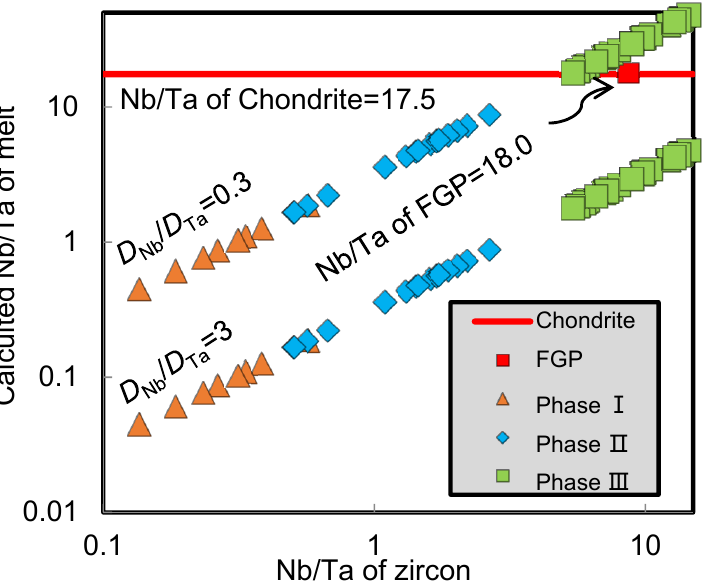
Figure 8. Nb/Ta ratio of zircon vs. Nb/Ta ratio of melt. Nb/Ta ratio of melt was calculated by using Nb/Ta ratio of zircon and D Nb / D Ta , assuming the two relatively extreme values of D Nb / D Ta = 0.3 and 3.